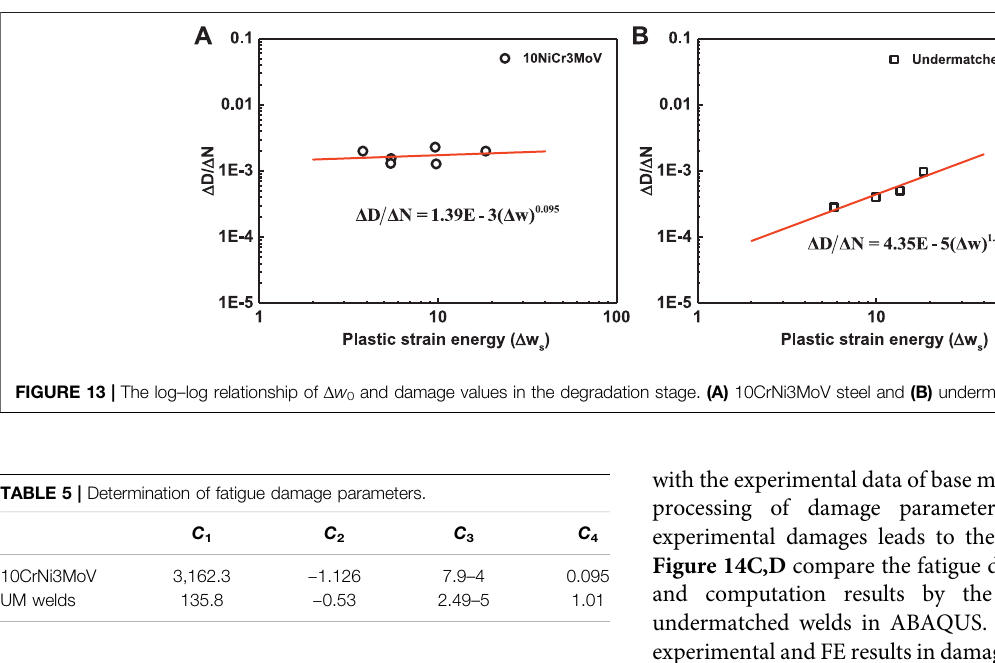
Frontiers in Materials |